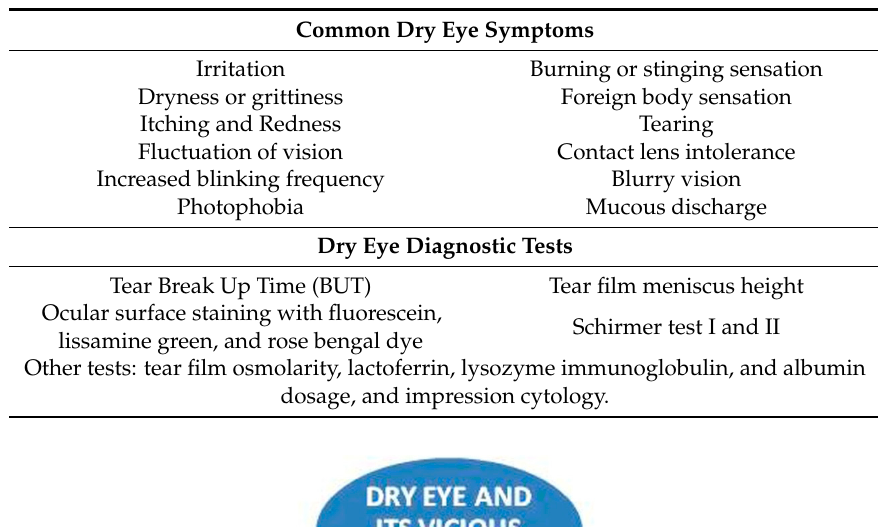
Table 1. Dry eye symptoms and diagnostic tests.